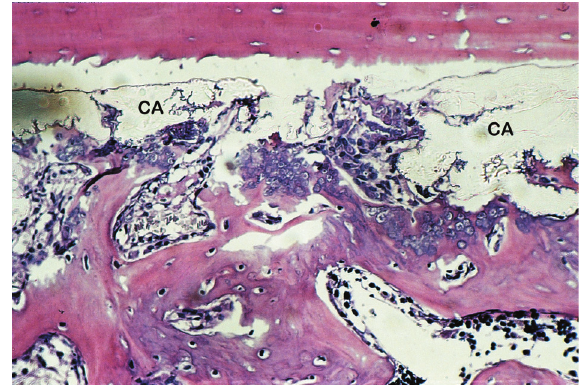
Figure 5- Group II – 30 days: New bone formation observed between the bone graft and the recipient site, in contact with